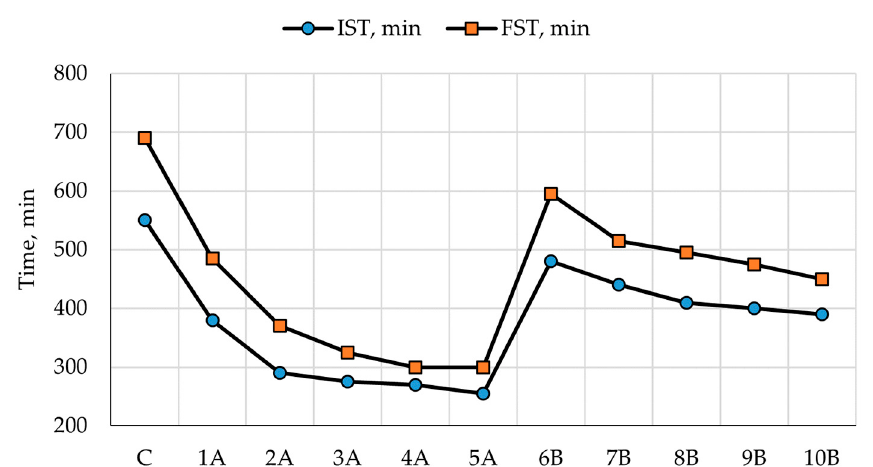
Figure 6. Dependence of changes in IST and FST on the content of stone flour: IST—initial setting time, FST—final setting time, C—control composition (without stone flour content), 1A–5A—marking of formulations with the addition of stone flour in the form of micro calcite, 6B–10B—marking